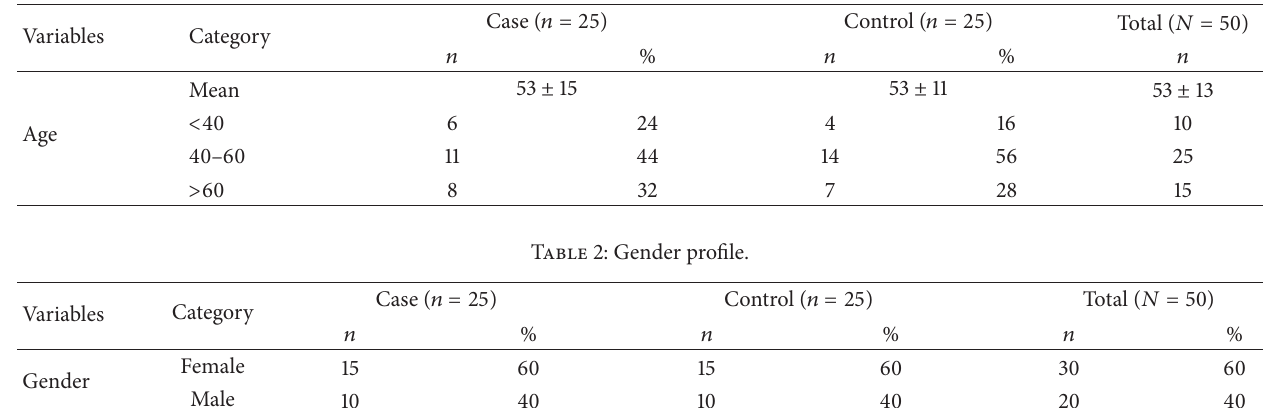
Table 1: Age profile.